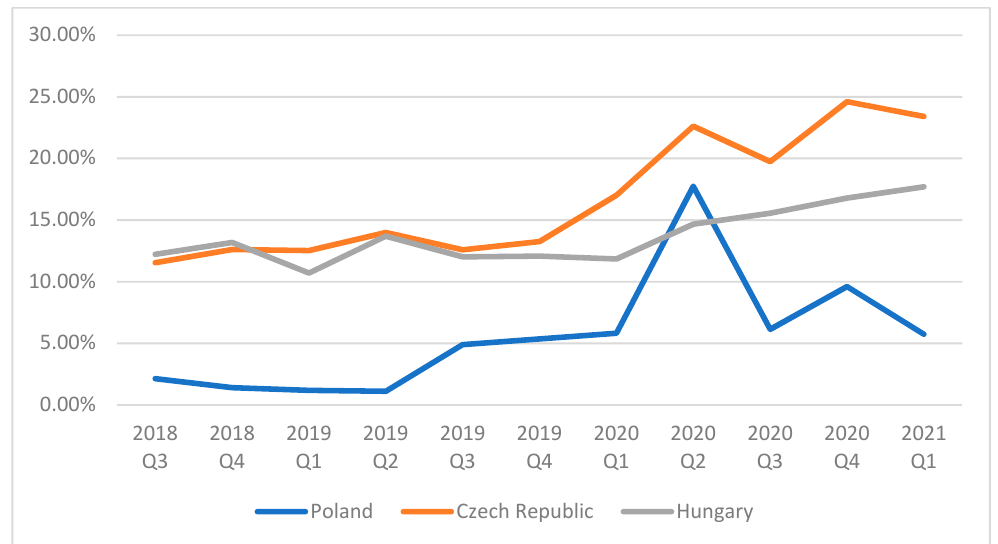
Figure 6. Consumer Confidence Index (CCI) in selected CEE states. Source: (OECD Database 2021).